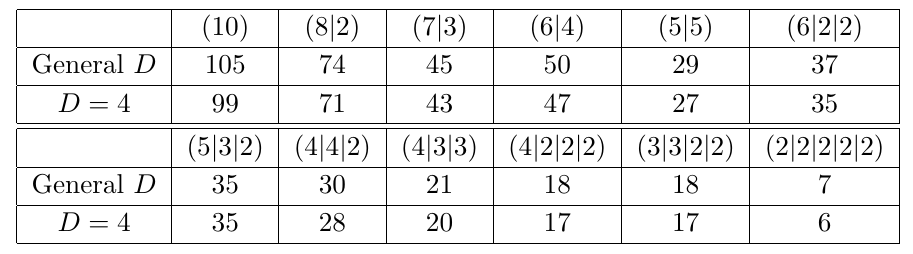
Table 8 . Number of independent 10-pt Soft Blocks at O ( p 10 ) for general spacetime dimensions D (given in [16]), and specifically for D = 4 using SSYT